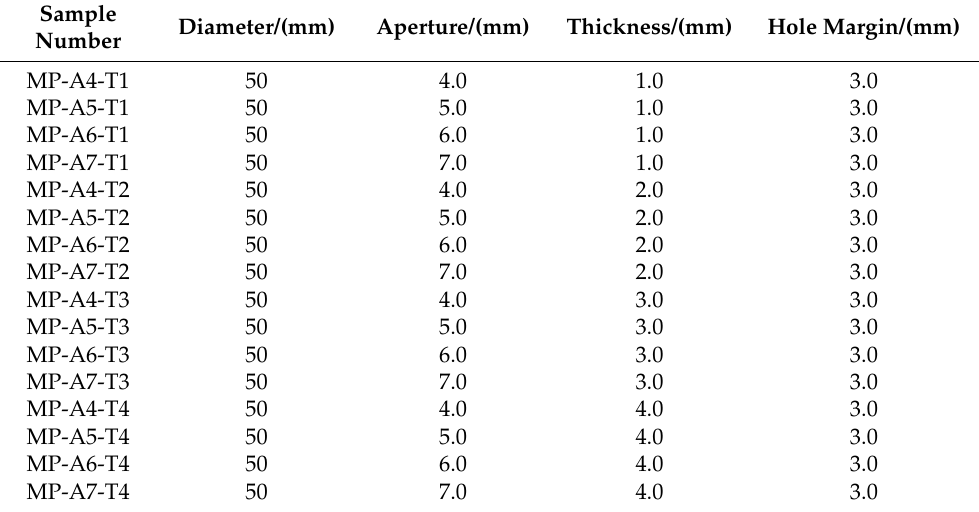
Table 1. Material parameters of wave-absorbing metal plate.